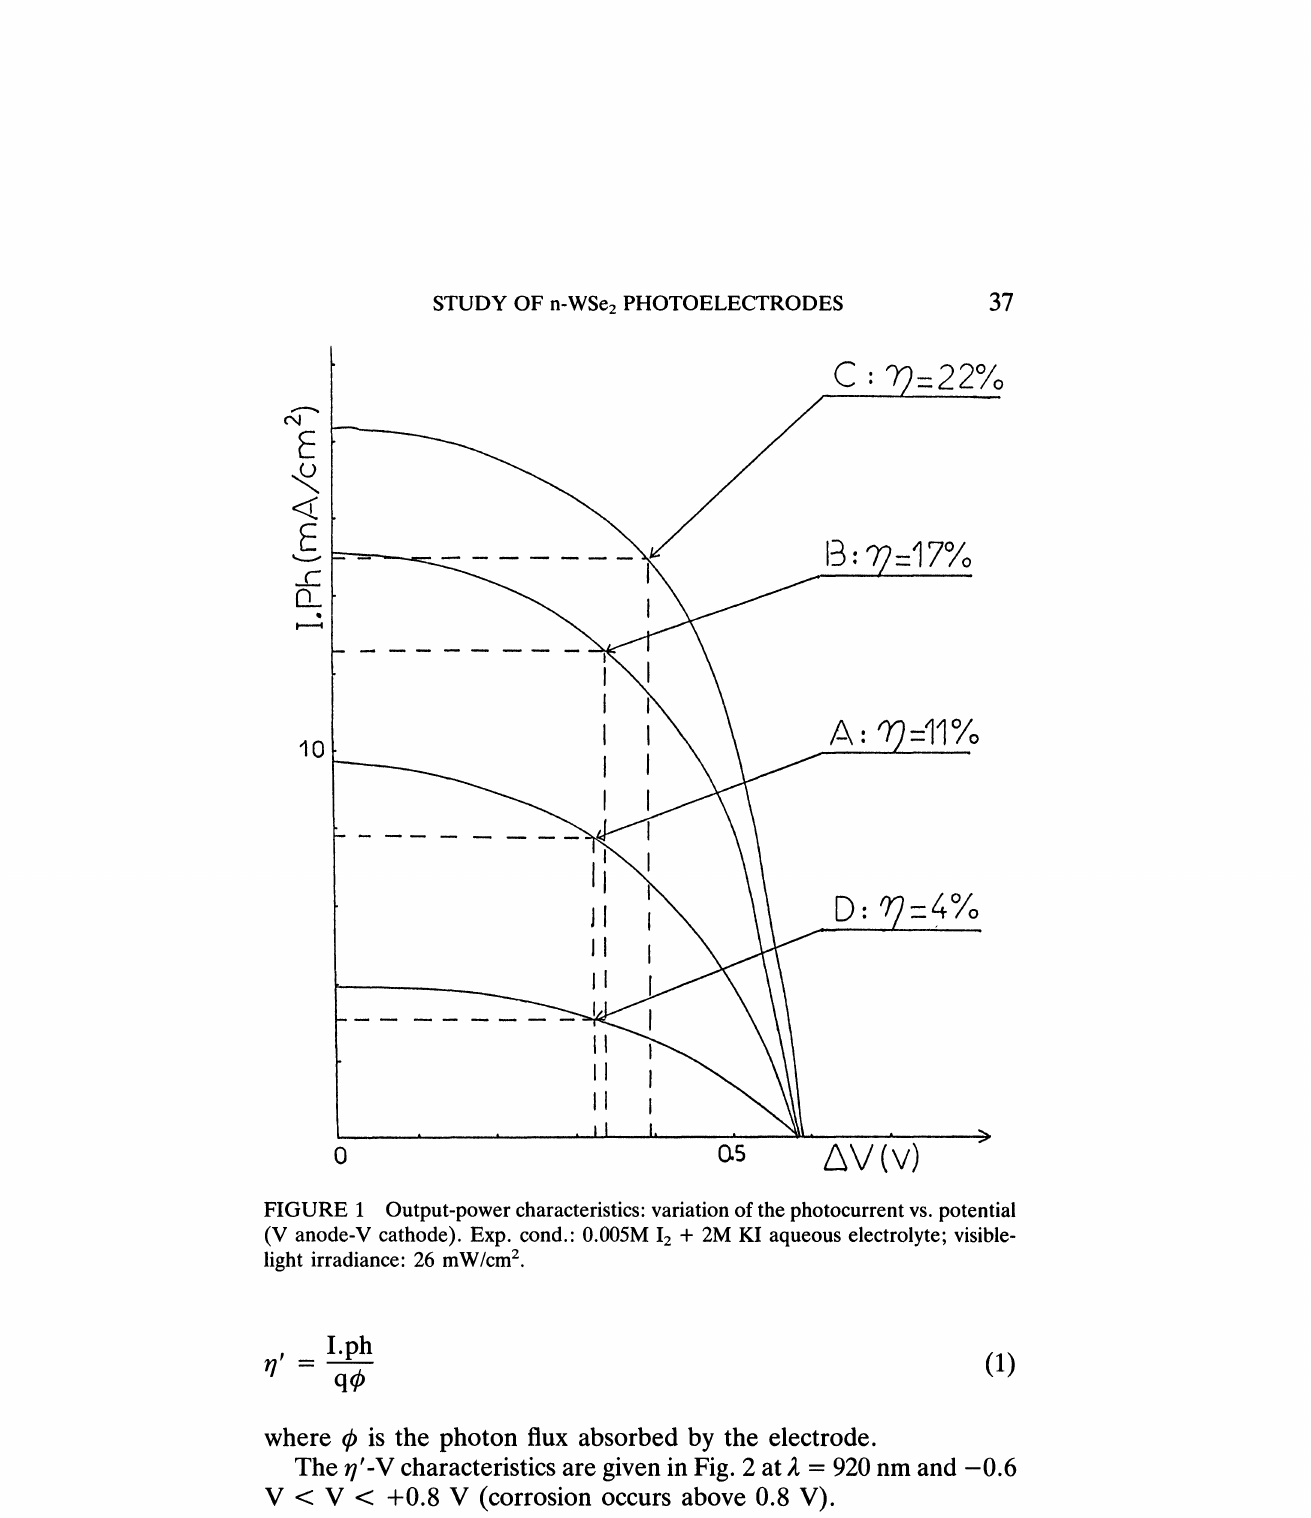
FIGURE Output-power characteristics: variation of the photocurrent vs. potential (V anode-V cathode). Exp. cond 0.005M 12 + 2M KI aqueous electrolyte; visible- light irradiance: 26 mW/cm